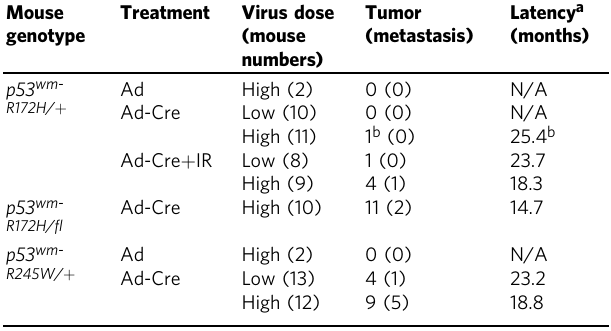
Table 1 Summary of mammary tumors developed from the Trp53 wm-R172H/ + (with or without γ -radiation treatment), Trp53 wm-R172H/ fl and Trp53 wm-R245W/ + mice subjected to low- or high-dose Ad-Cre